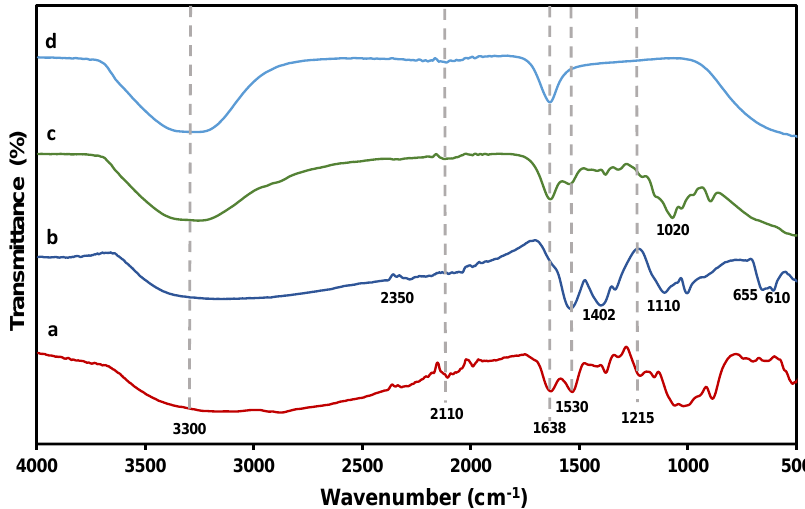
Figure 4. FTIR spectral comparison of ( a ) CS, ( b ) Mn:ZnS, ( c ) MMC@CS-Mn:ZnS, and ( d ) MMC samples. Table 1. Absorption peaks for different functional groups in NPs.